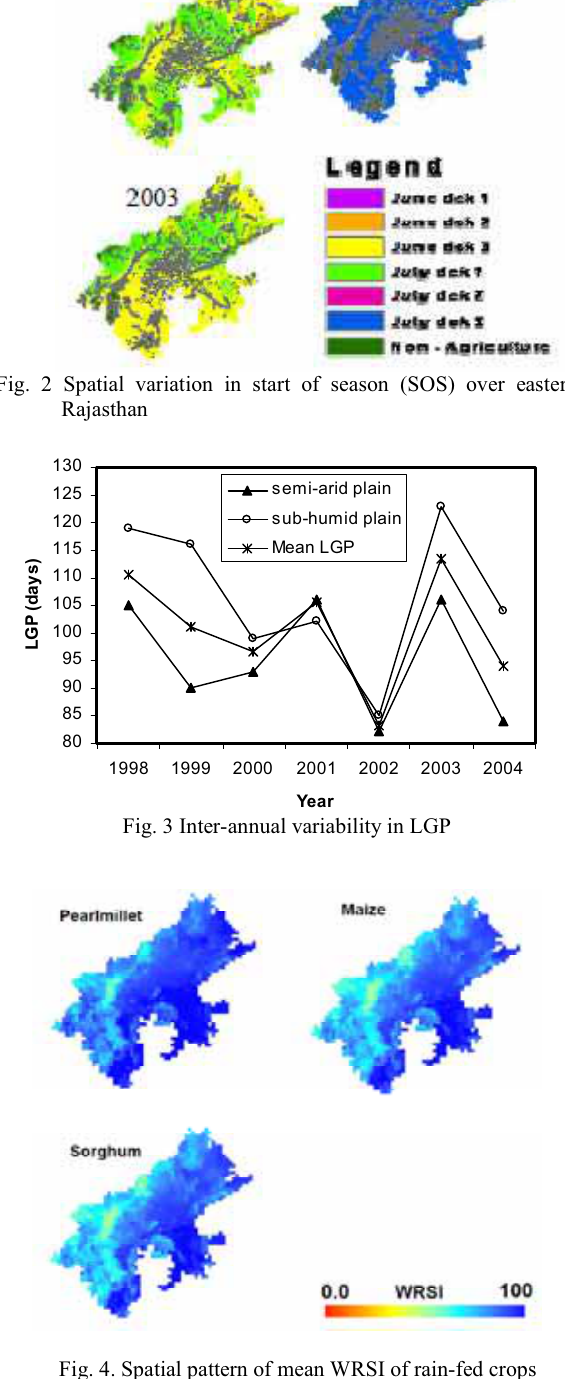
Fig. 4. Spatial pattern of mean WRSI of rain-fed crops